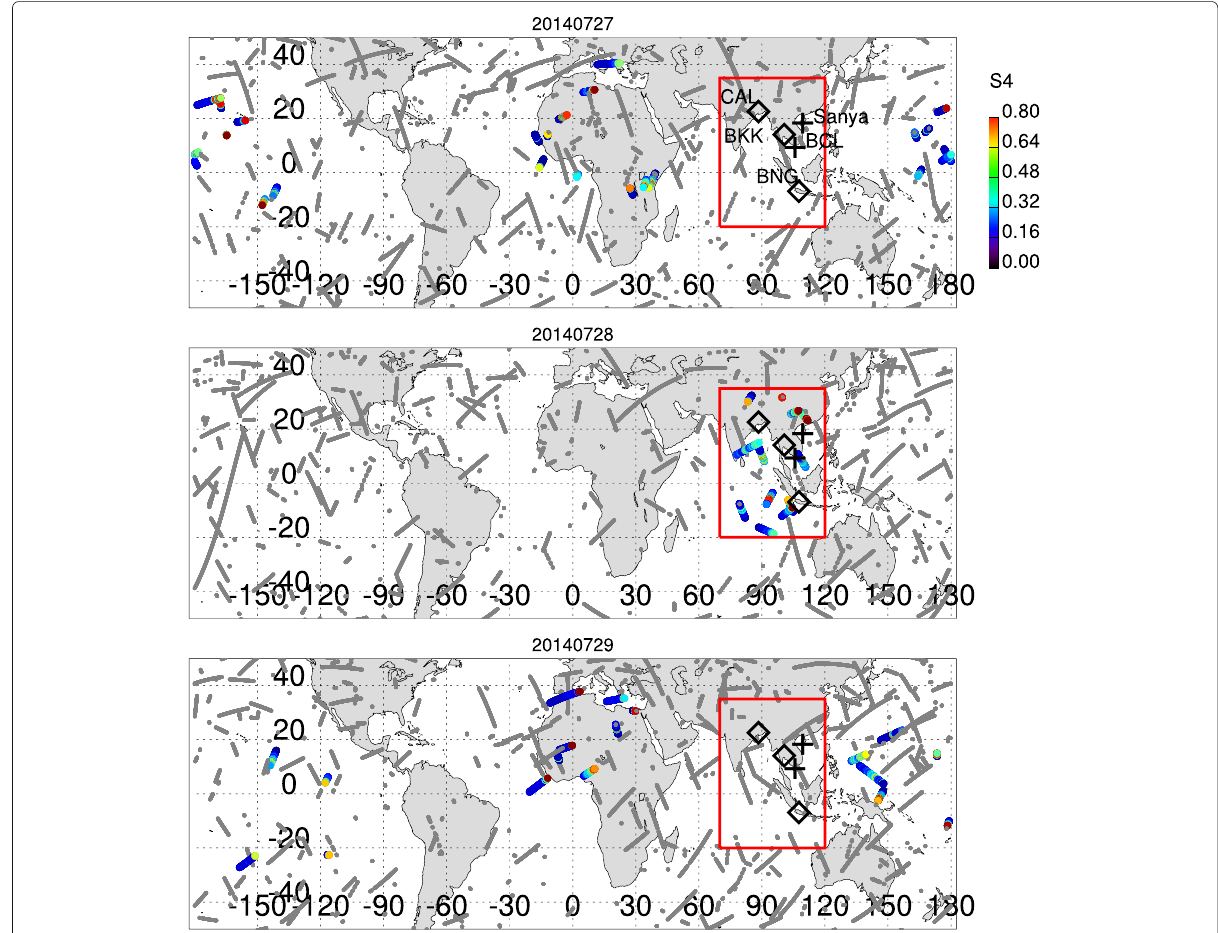
Fig. 2 Global maps showing the locations of COSMIC RO events for which the detected scintillation level “S4max9sec” exceeded 0.3 at F-region altitudes (150–400 km) during the post-sunset hours (i.e., 19–00 LT) of 27 July 2014 (top panel), 28 July 2014, (middle panel), and 29 July 2014 (bottom panel). Also shown are the locations of the SCINDA GPS stations (diamonds) and the Sanya and BCL ionosondes (crosses). The gray points show post-sunset COSMIC RO events with scintillation levels that did not exceed 0.3 at F-region altitudes. The red rectangle highlights the Southeast Asian sector that is analyzed further in Fig.